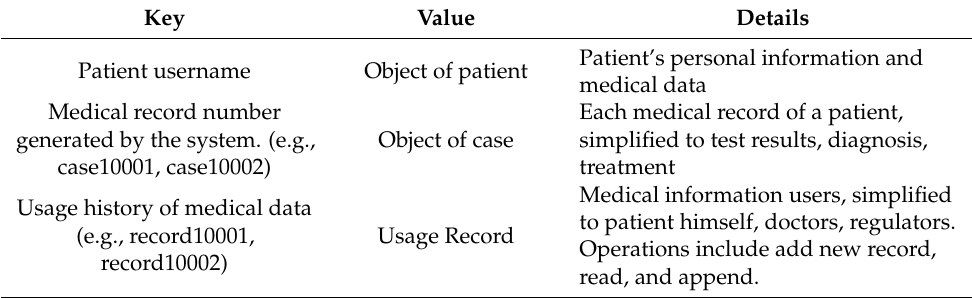
Table 1. Data types of the